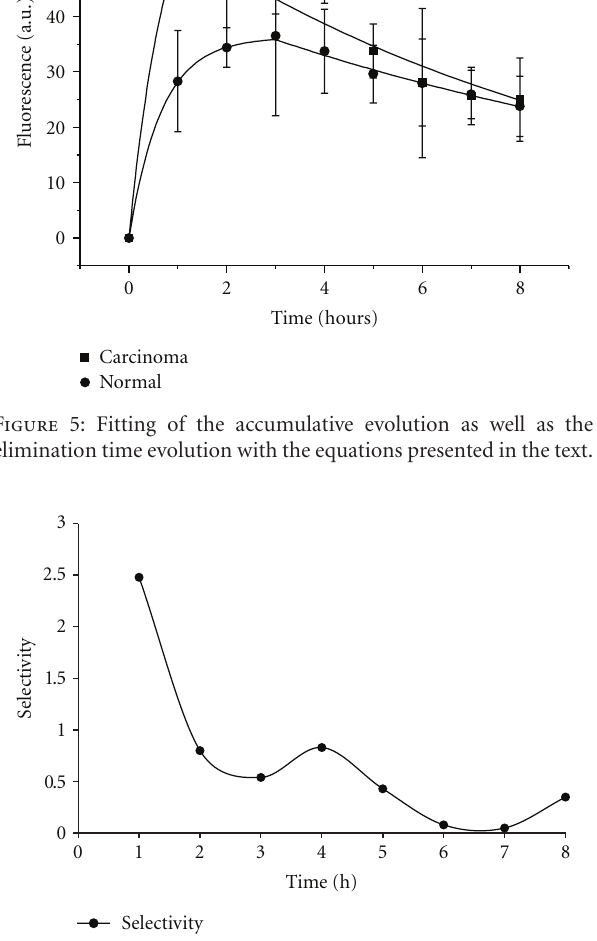
Figure 6: Fitting of the selectivity ratio between tumor and normal tissue. Table 2: Time for accumulation ( T acc ) and elimination ( T elim ) of the photosensitizer obtained for the normal and colon carcinoma, presented both in minutes.